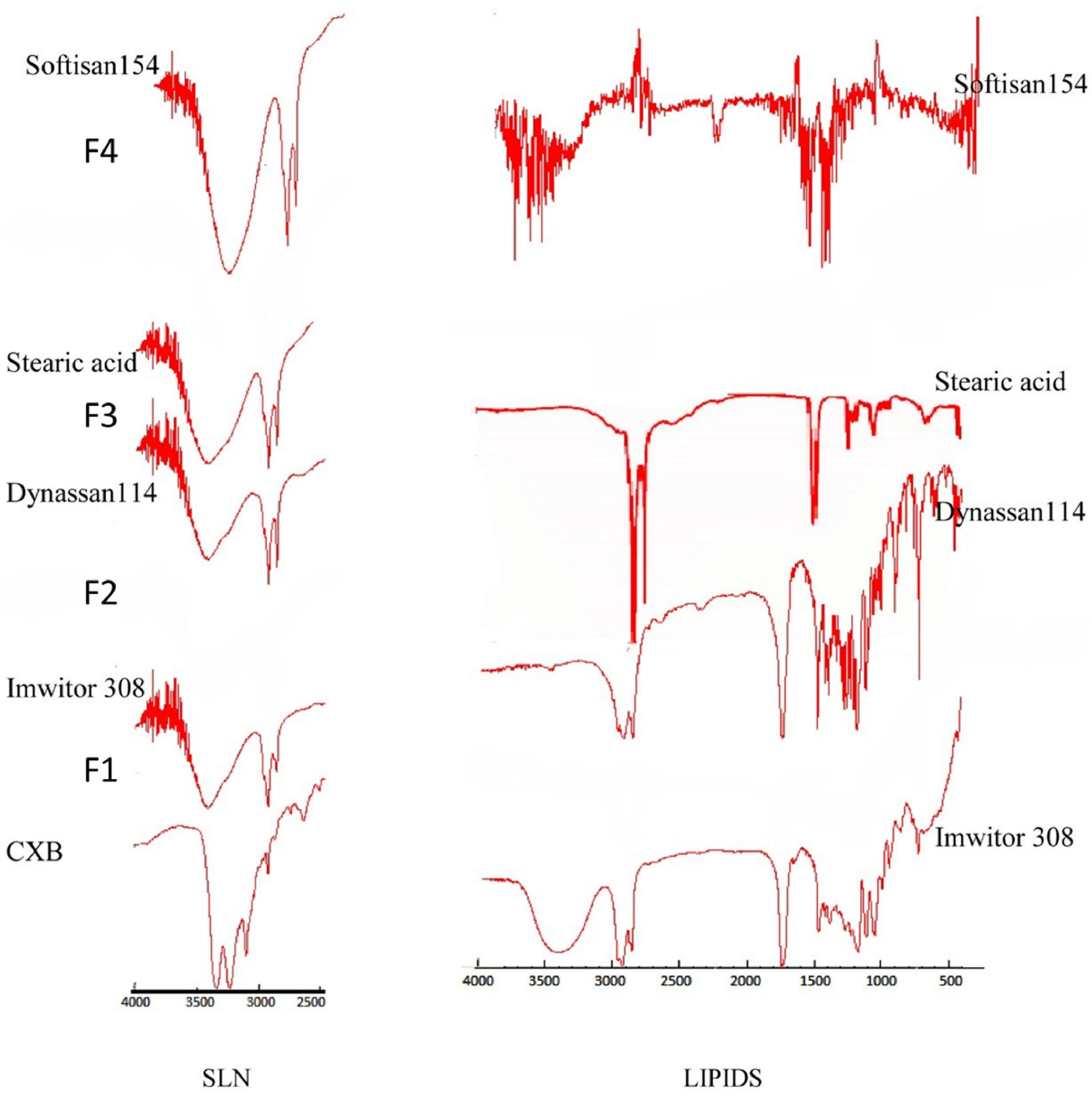
Figure 3. FTIR spectra of all lipids and all SLN formulations.